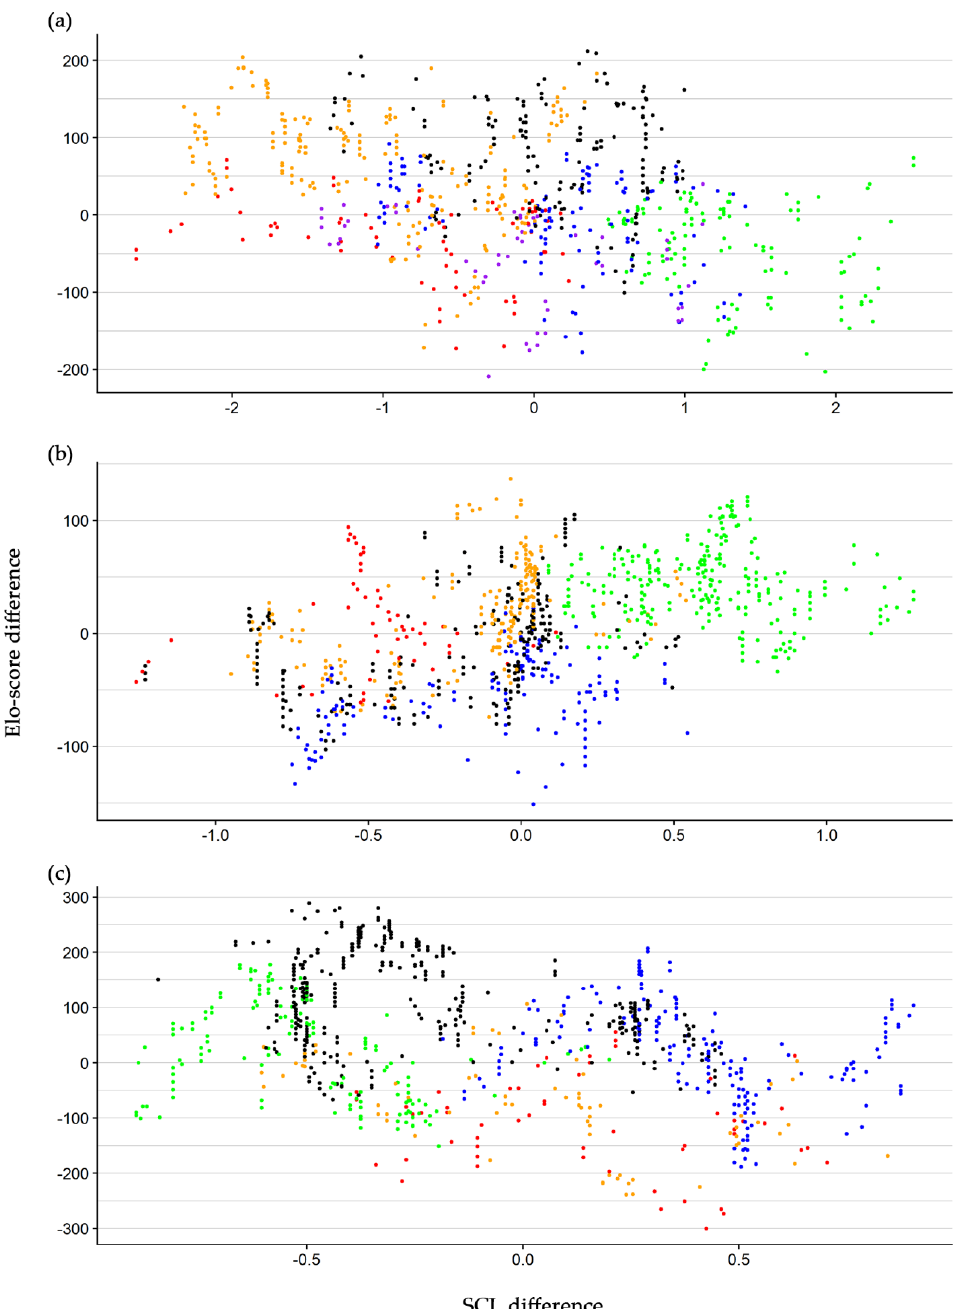
Figure 5. Relationship between the difference in Elo-score and the difference in straight carapace length (SCL) before the interactions occurred. Each dot represents a single dyadic interaction and its colors identify the winning individual. Group one ( a ): ID 7 (green), 12 (purple), 13 (black), 14 (orange), 15 (blue), 16 (red). Group two ( b ): ID 1 (orange), 2 (black), 4 (green), 9 (blue), 10 (red). Group three ( c ): ID 3 (green), 5 (black), 6 (red), 8 (orange), 11 (blue).